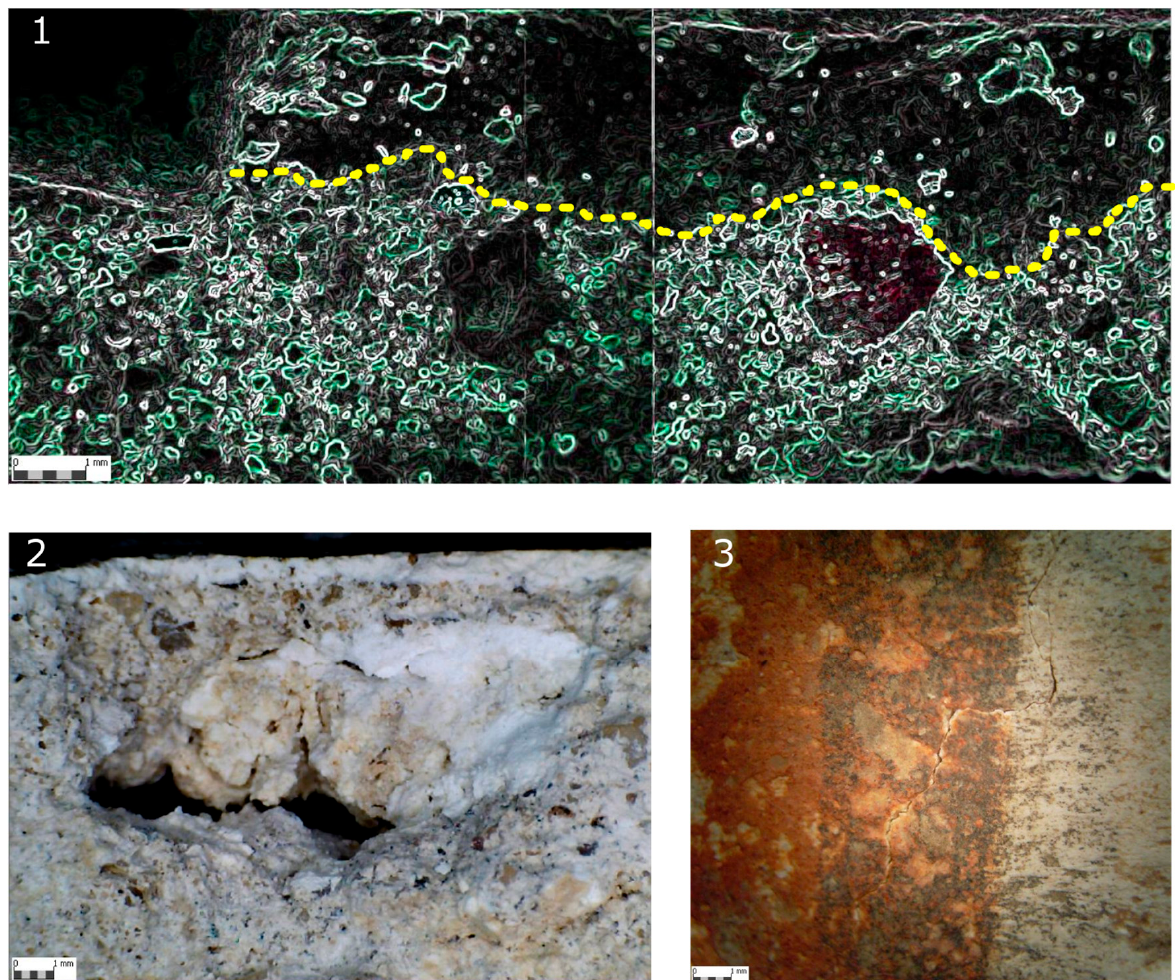
Figure 7. (1) Sobel treatment in sample NO4 showing the difference (separated by yellow dashed line) between the outside layer (less presence of aggregates) and inside (arriccio and intonaco). (2) Sample NO2 with recalcification in the pores (left). (3) Spatula marks on the surface of sample NO7.